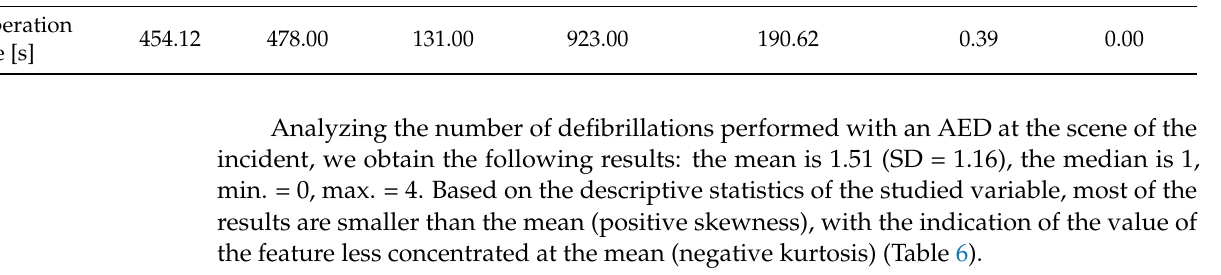
Table 6. Basic descriptive statistics on the number of defibrillations performed with using an AED (n = 33). Mean Median Minimum Maximum Standard Deviation Skewness Kurtosis number of AED 1.51 1.00 0.00 4.00 1.16 0.34 − defibrillations